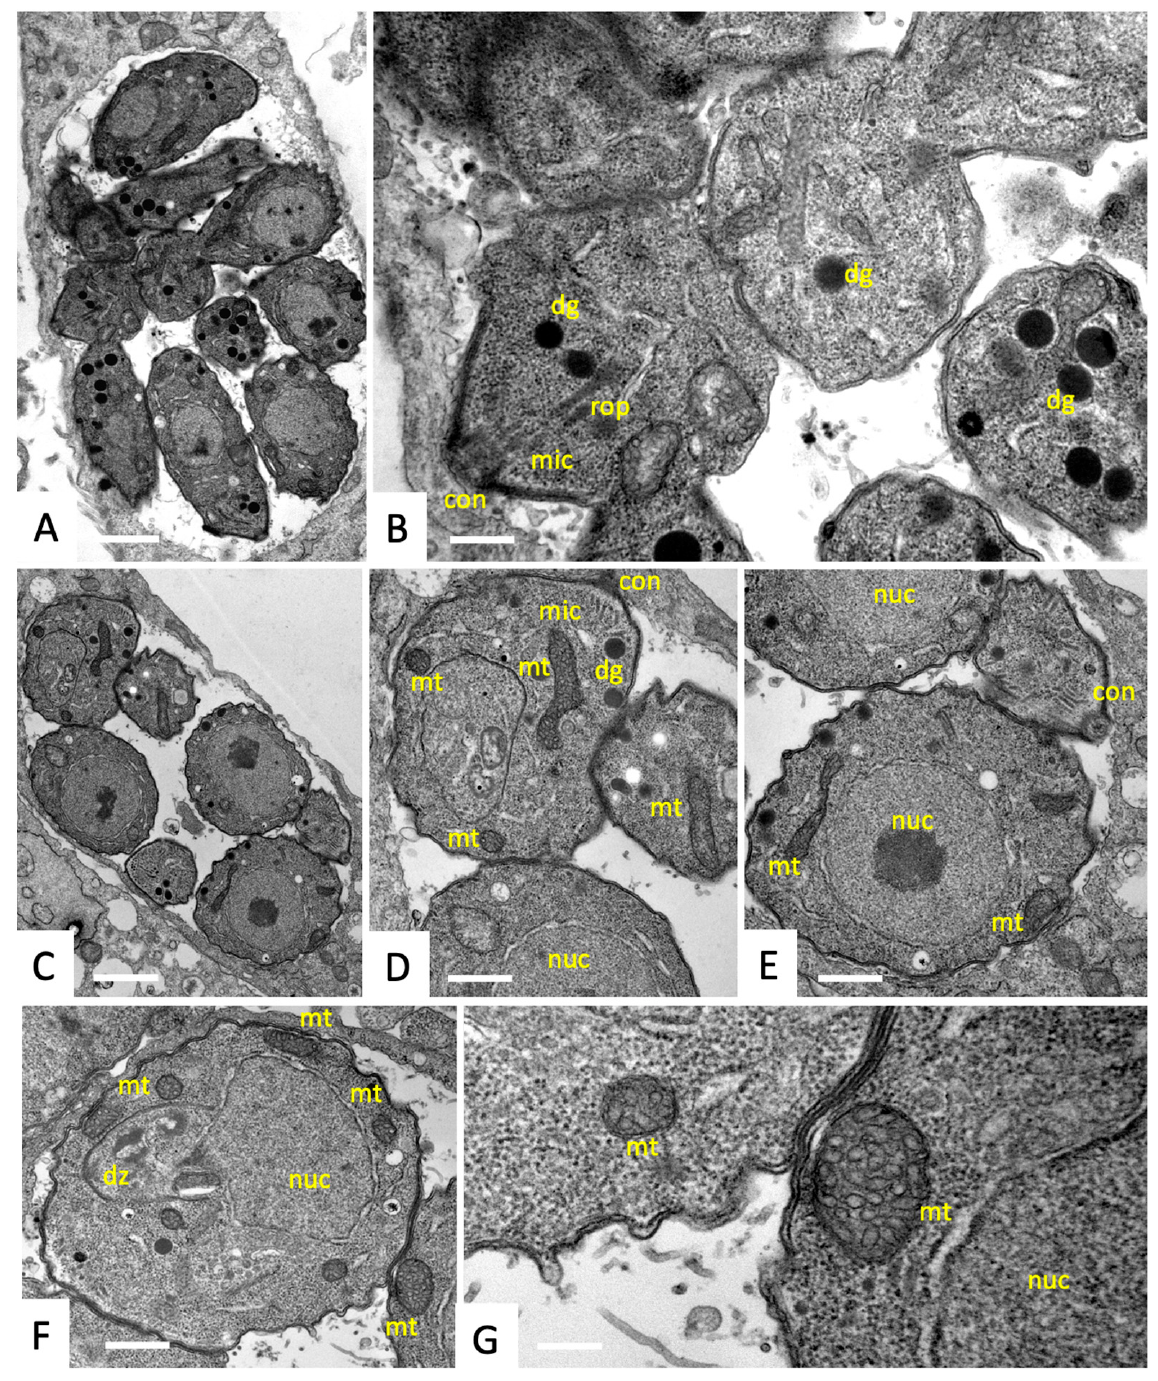
Figure 2. Ultrastructure of T. gondii tachyzoites cultured in human foreskin fibroblasts (HFF). Para- sites proliferated intracellularly within a parasitophorous vacuole ( A , C ), and corresponding higher magnification views are depicted in ( B ) and ( D – E ). A tachyzoite undergoing endodyogeny forming a daughter zoite (dz) is shown in ( F ), and structural details of the mitochondrion are shown at higher magnification in ( G ). Notice distinct apicomplexan organelles at the anterior end of tachyzoites such as the conoid (con), rhoptries (rop) and micronemes (mic). Dense granules (dg) and parts of the mitochondrion (mt) are dispersed within the cytoplasm; nuc = nucleus. Bars in ( A ) = 1 µm; ( B ) = 0.35 µm; ( C ) = 1 µm; ( D ) = 0.55 µm; ( E ) = 0.42 µm; ( F ) = 0.55 µm; ( G ) = 0.18 µm.